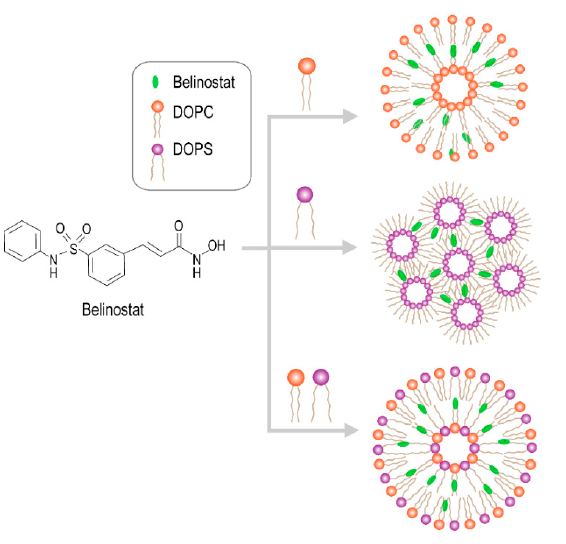
Figure 1. Schematic diagram of various liposomes incorporating dioleoylphosphatidylcholine (DOPC), dioleoylglycerophosphoserine (DOPS), and DOPC/DOPS mixture.